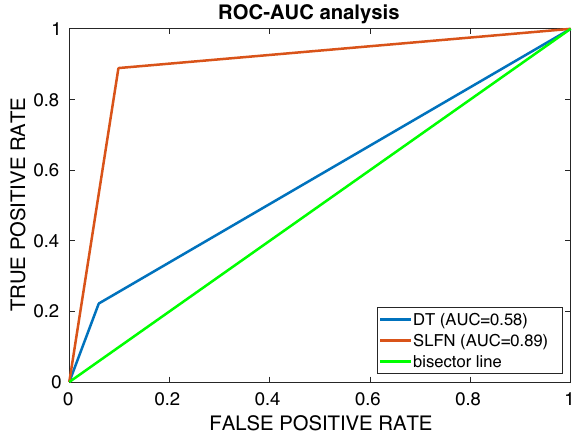
Figure 1. ROC-AUC analysis for the SLFN and DT